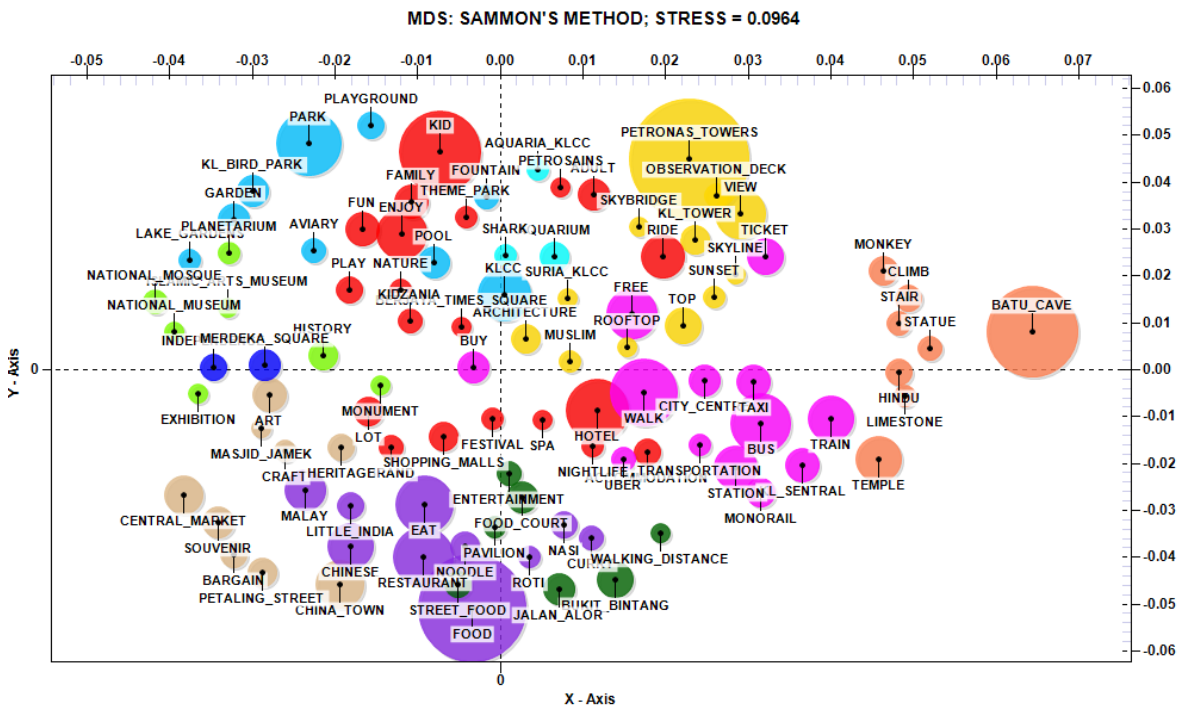
Figure 3. Bubble plot multidimensional scaling (MDS) representation for POI–Feature keywords.